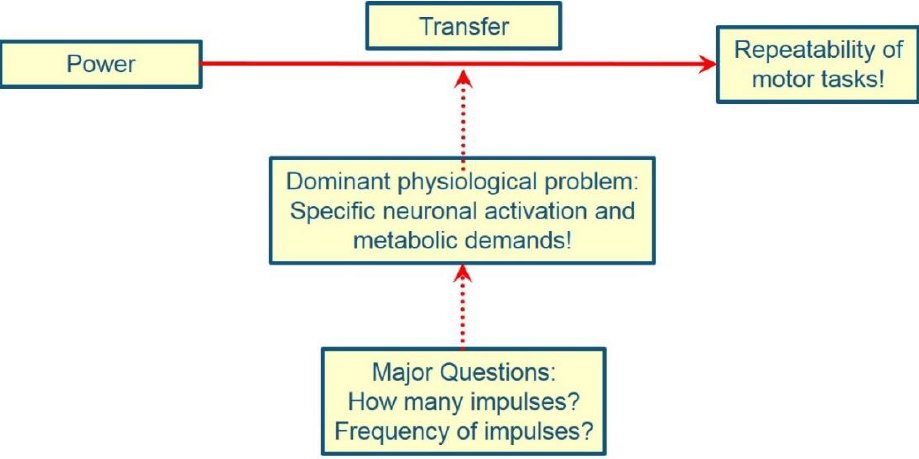
Figure 4. Development of the reproducibility of large impulses in cyclic